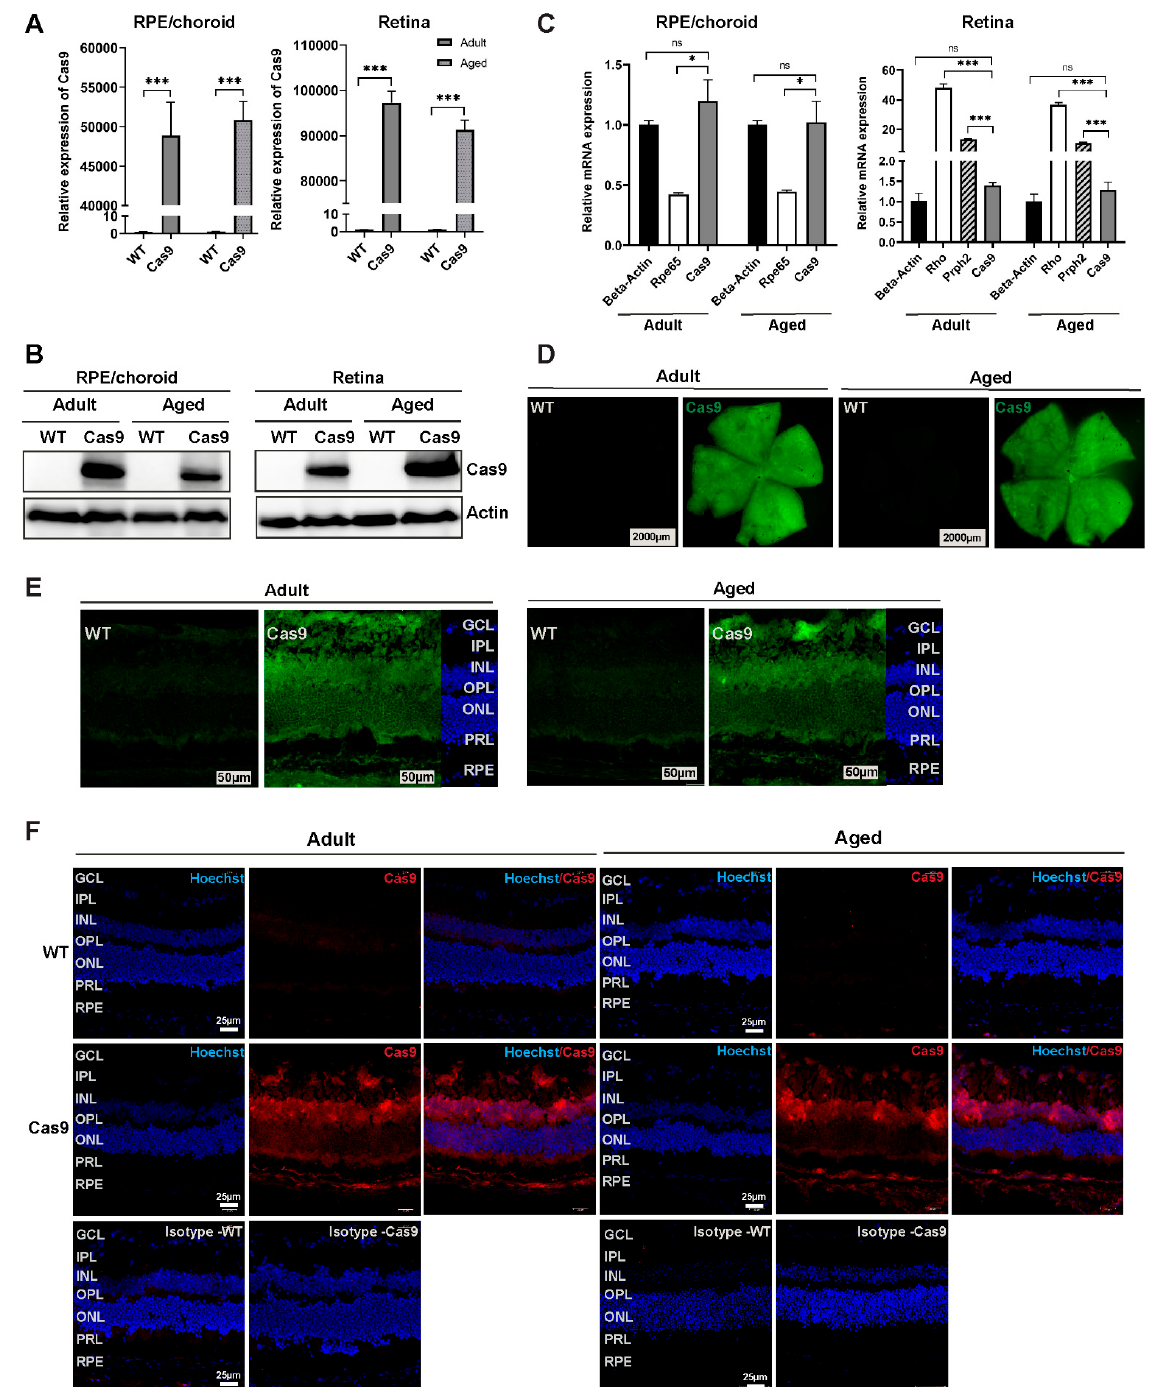
Figure 1. Evaluation of SpCas9 expression in RPE/choroid and retina of WT and Cas9 mice. ( A ) qPCR analysis of RPE/choroid and retinal tissues reveal abundant Cas9 expression in the adult and aged Cas9 mice (n = 5–6 per group; *** p < 0.001). Statistical significance was determined by Mann–Whitney U test; error bars depict SEM. ( B ) Representative Western blots show Cas9 expression in RPE/choroid and neural retina of adult and aged Cas9 mice. β -actin served as the loading control. ( C ) Relative expression of Cas9 in RPE/choroid and retina of adult and aged Cas9 mice with respect to the beta-actin, Rpe65 (RPE/choroid), and Rho; Prph2 (retina) was determined by qPCR (n = 5–6 per group, * p < 0.05, *** p < 0.001, ns, no significance). All qPCR data were normalized to GAPDH and er- ror bars were represented as SEM. ( D ) Fluorescence images of retinal flat mounts from adult